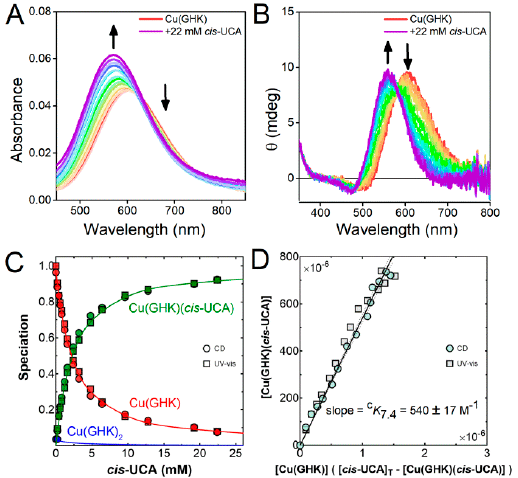
Figure 5. The conditional Cu(II) binding constant c K 7.4 = [Cu(GHK)( cis -UCA)] / ([Cu(GHK)][ cis -UCA]). ( A ) UV-vis, and ( B ) CD spectra of Cu / GHK / cis -UCA 0.8:0.95: n (0 ≤ n ≤ 22 mM) at pH 7.4, 25 ◦ C. ( C ) Speciation of GHK complexes obtained from decomposition of UV-vis and CD spectra in dependence of cis -UCA concentration. ( D ) Determination of the binding constant c K 7.4 using least squares regression. The margin of error derives from the 95% confidence interval dashed